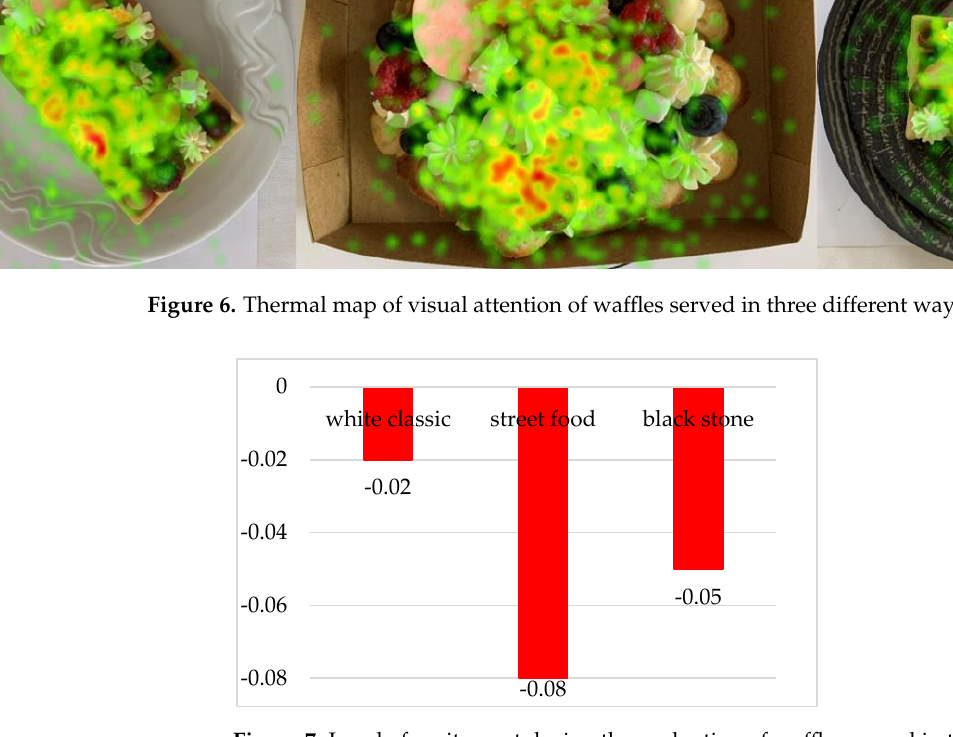
Figure 7. Level of excitement during the evaluation of waffles served in three different ways.